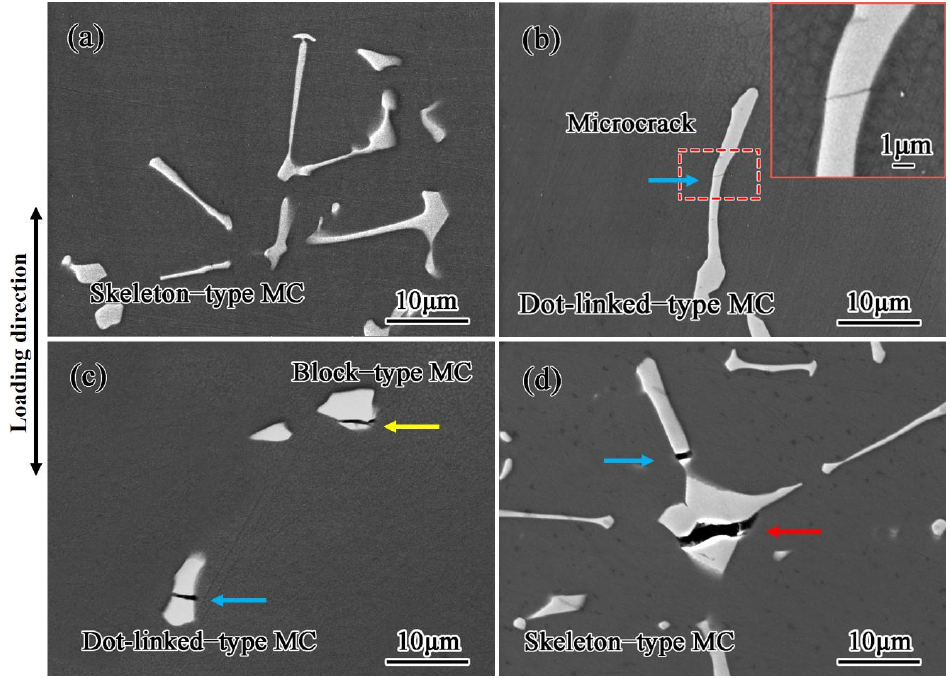
Figure 5. Micrographs of the MC carbides at different residual strains. ( a ) No microcrack was found in the strain of 0% (I). ( b ) A tiny microcrack was observed in dot-linked-type carbide at the strain of 0.2% (II). ( c ) The microcracks can be clearly identified at the strain of 5.0% (III). ( d ) The microcrack size is related to the MC carbide morphology at the strain of 10.2% (IV).